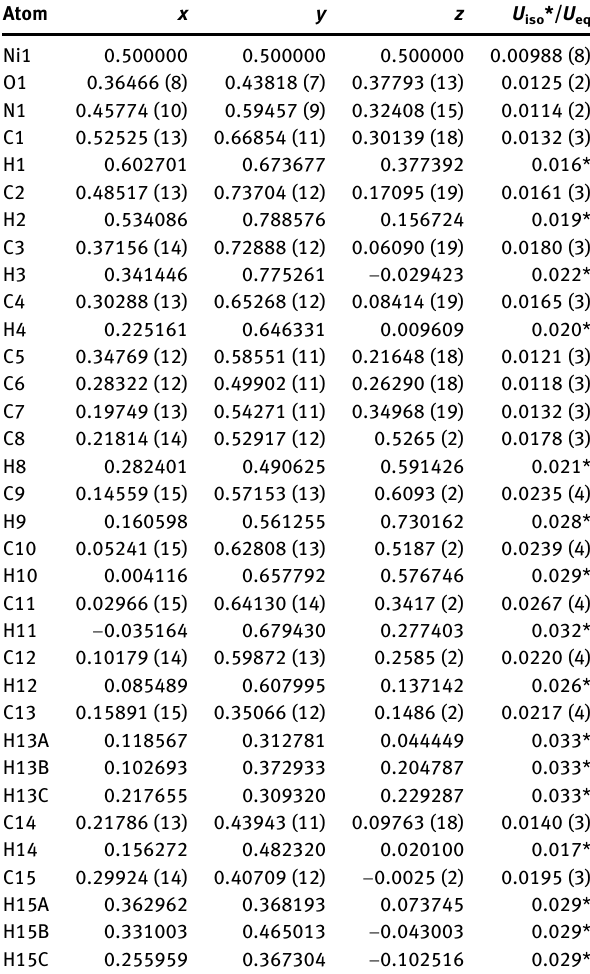
isotropic displacement parameters (Å 